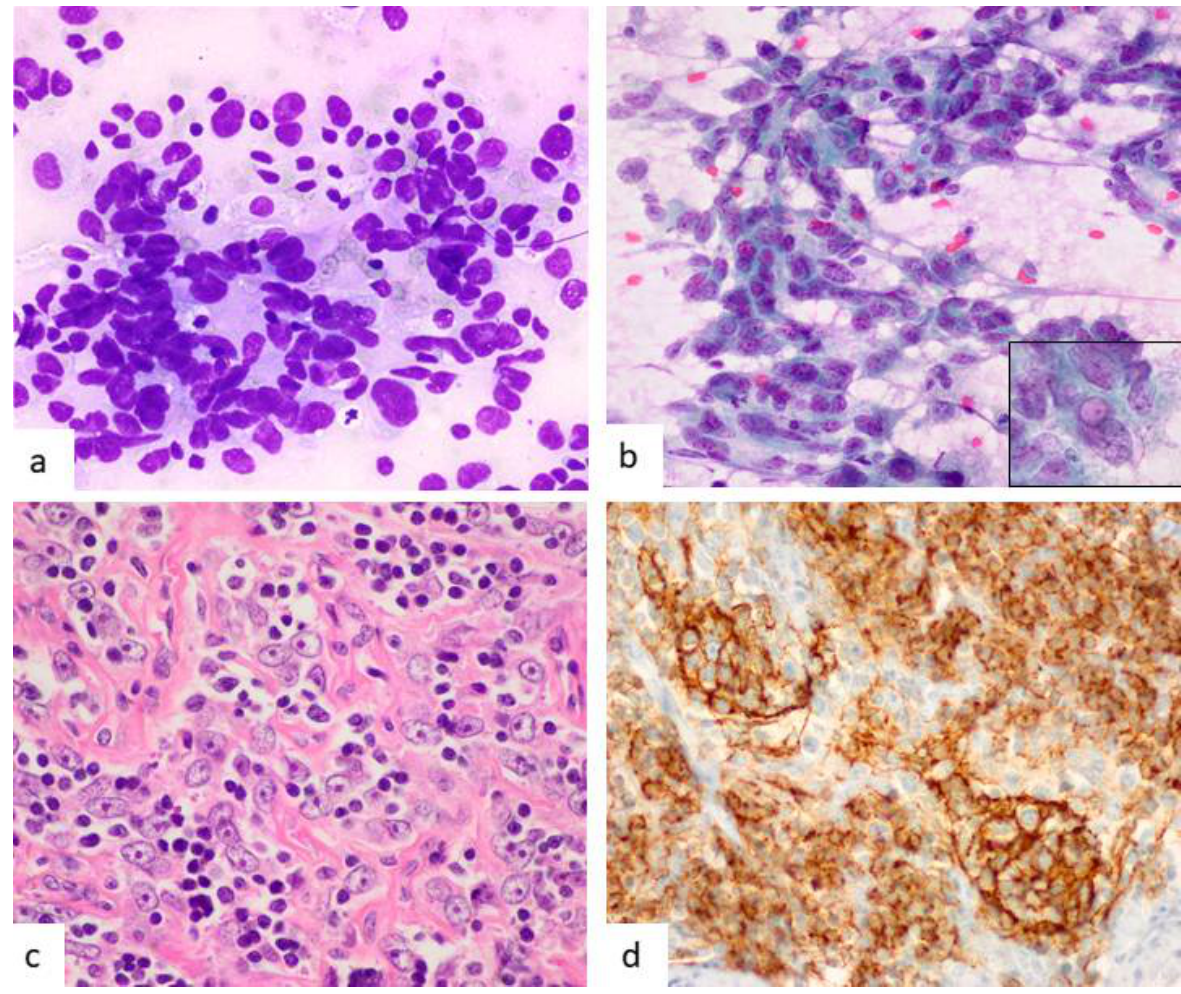
Figure 3. A case of follicular dendritic cell sarcoma in a bronchial lymph node. ( a ) Irregular clusters and single pleomorphic large tumoral cells with lymphocytes. Most cells have oval nuclei (Diff-Quik, ×400). ( b ) Cells showed slender, elongated cytoplasmic processes and spindle cell morphology. The inset shows a nuclear pseudoinclusion (both Papanicolaou, ×400). ( c ) Histology is characteristic with a dimorphic cell pattern of lymphocytes and large tumoral cells with oval nuclei and evident nucleoli (HE, ×400). ( d ) Neoplastic cells showing intense CD35 expression (immunoperoxidase, ×400).